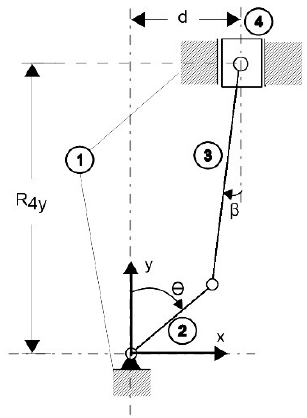
Figure 2. Scheme kinematic model for decentered sliding rod-crank-mechanism.